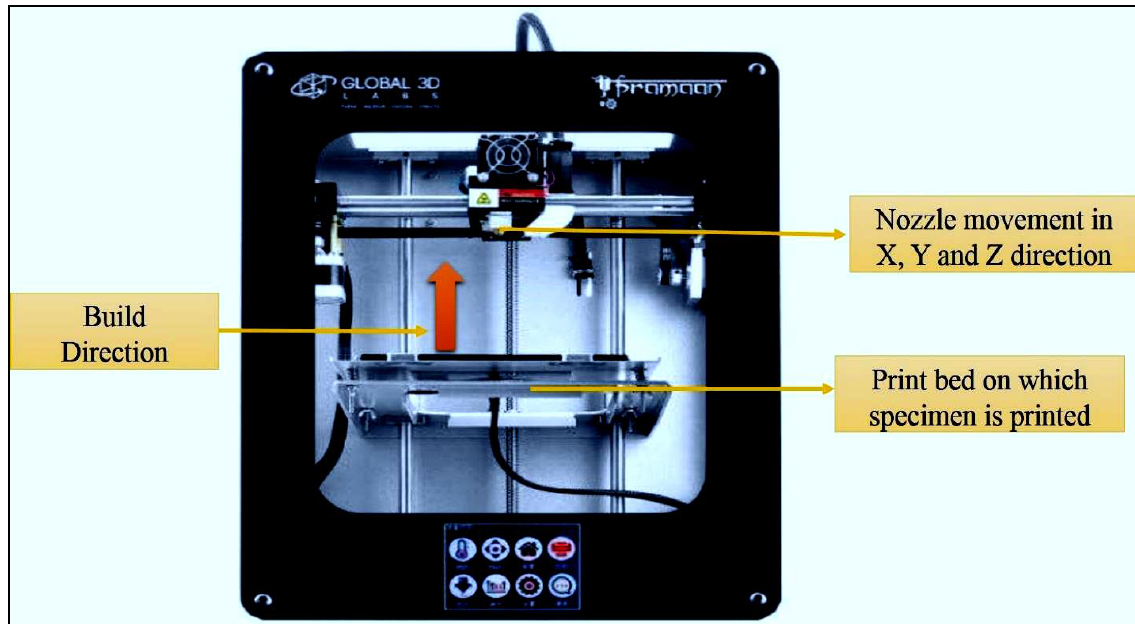
Figure 5. Photograph of FDM machine used for fabrication of parts. For dimensional accuracy, rectangular components of 10 × 10 × 10 mm were developed using FDM. The identical specimens were used for the measurement of surface roughness. Three trials were conducted for length, breadth, and height, and the average value was taken for all axes and compared using a digital Vernier calliper. The instrument was Mitutoyo Corp. (Made in Japan) model number 500-196-200. With the assistance of a surface roughness tester from Miyu (M35:2010), the Ra (surface roughness) for the FDM parts was measured. A specimen measuring 10 × 10 × 20 mm was developed for the Ra (surface roughness) measurement, on which three trials were conducted at different surface lengths, and the roughness ’ s average value was examined. The concerned profile ’ s arithmetic mean deviation was represented by Ra.